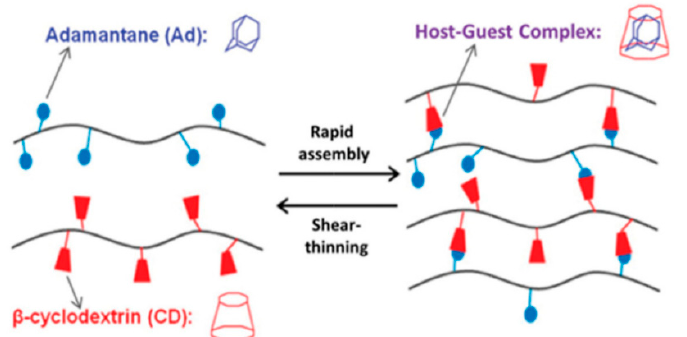
Figure 5. The host–guest interaction between β -cyclodextrin and adamantine. Reprint with permis- sion [36]; Copyright 2019, Wiley.